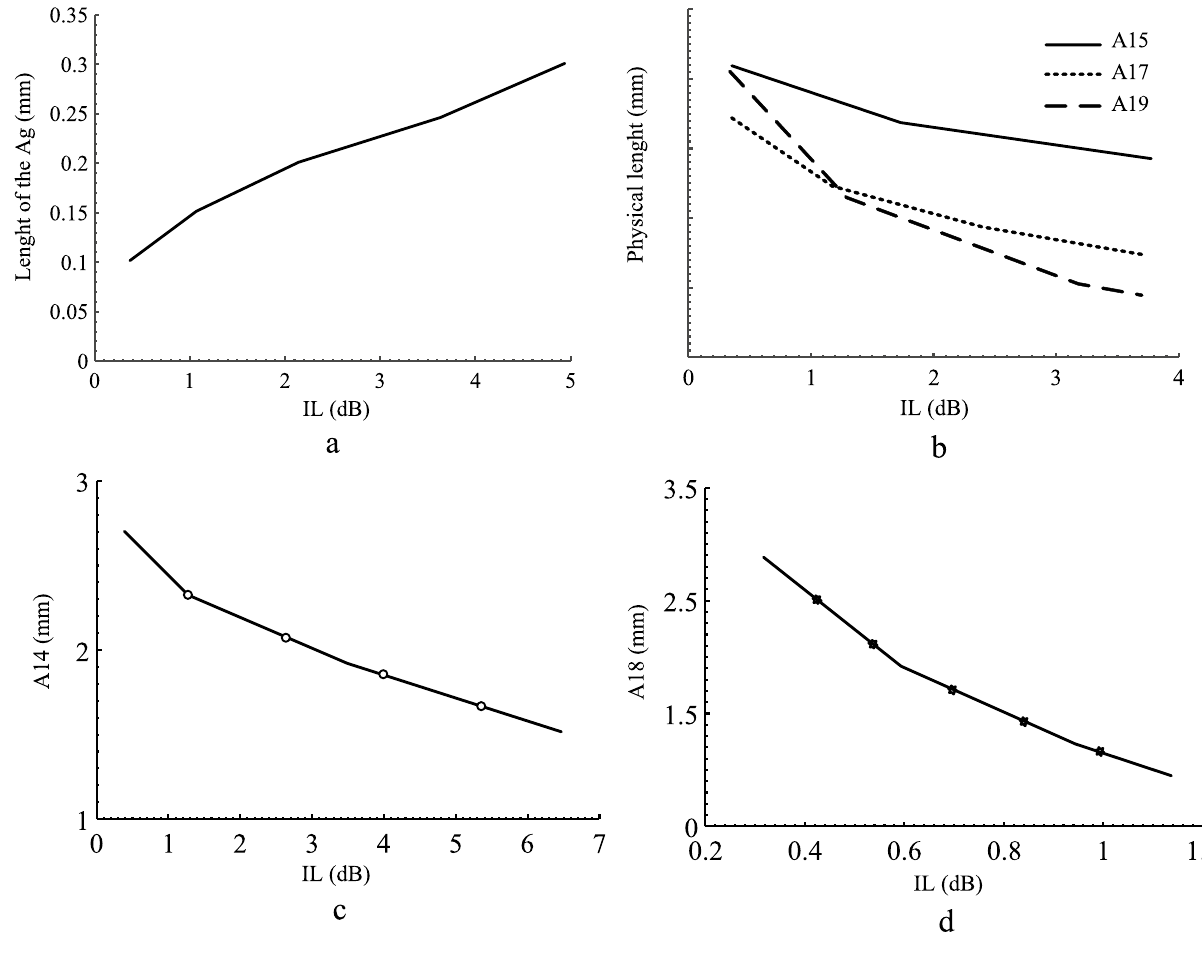
Figure 8. Proposed BPF: ( a ) Variations of IL versus A g , ( b ) Variations of IL versus A 15 , A 17 and A 19 , ( c ) Variations of IL versus A